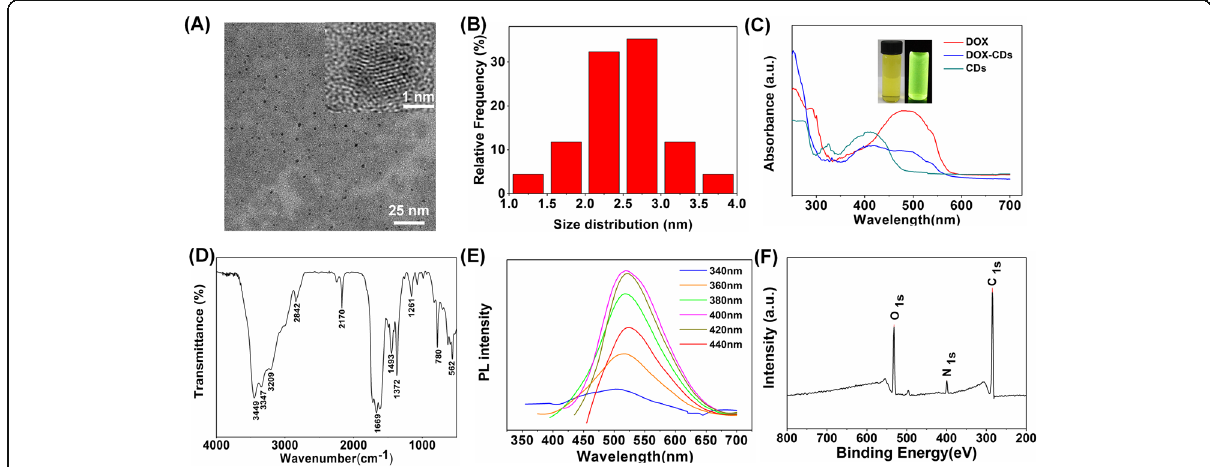
Fig. 1 Characterizations of CDs. a TEM images of CDs (inset, high-resolution TEM images). b Size distribution of CDs. c UV-vis absorption of DOX, CDs, and DOX-CDs and inset pictures show the CDs under natural light and UV light. d FTIR spectra of CDs and e The PL emission of CDs with excitation wavelengths from 340 nm to 440 nm in 20 nm increments. f XPS spectrum of